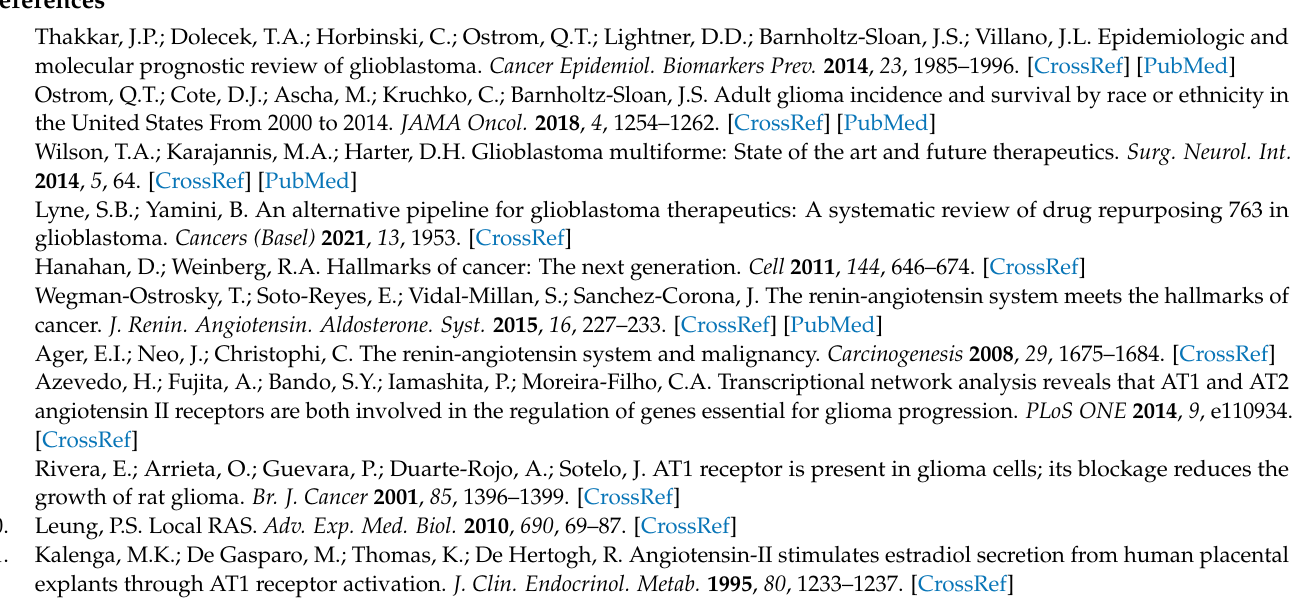
Table S1: Oligonucleotide primers for real-time PCR assays, Table S2: Oligonucleotide primers for DAPA